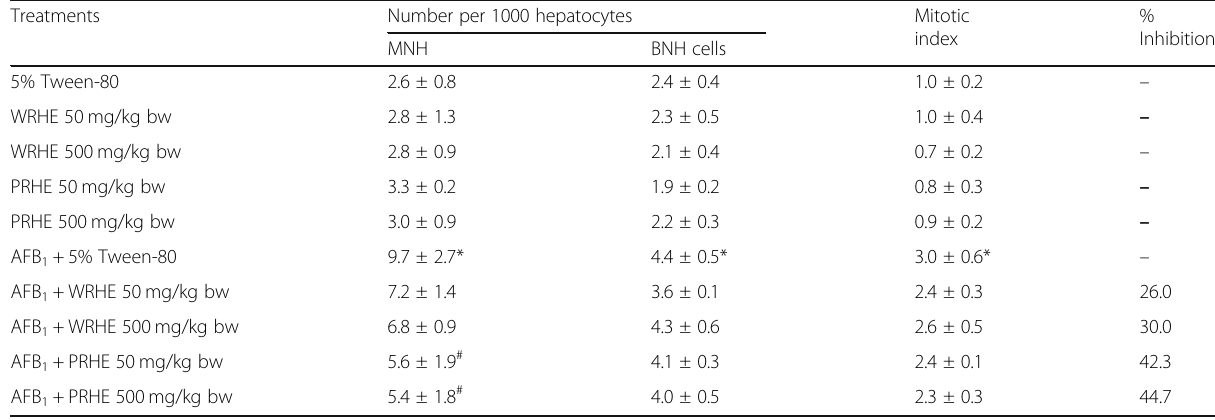
Table 2 Genotoxicity and antigenotoxicity of rice husk extracts in rat liver Treatments